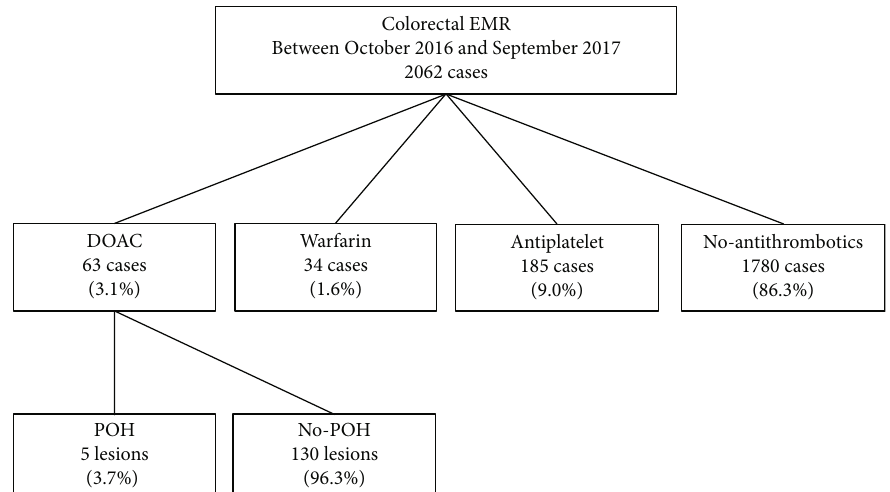
Figure 1: Study fl